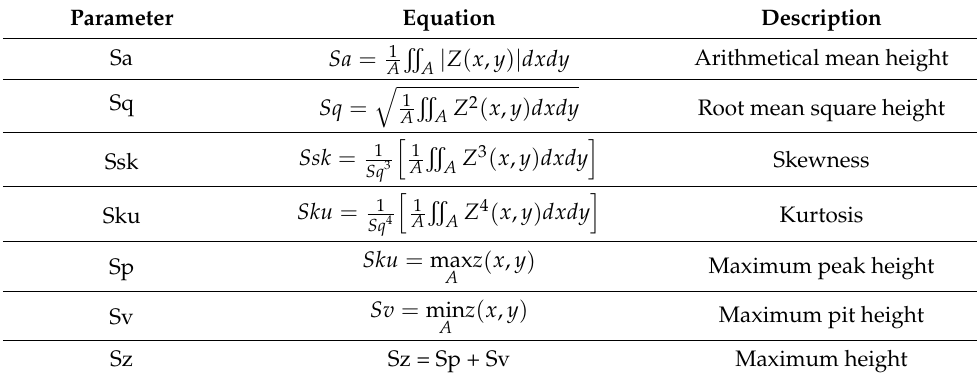
Table 2. Roughness parameters according equation ISO